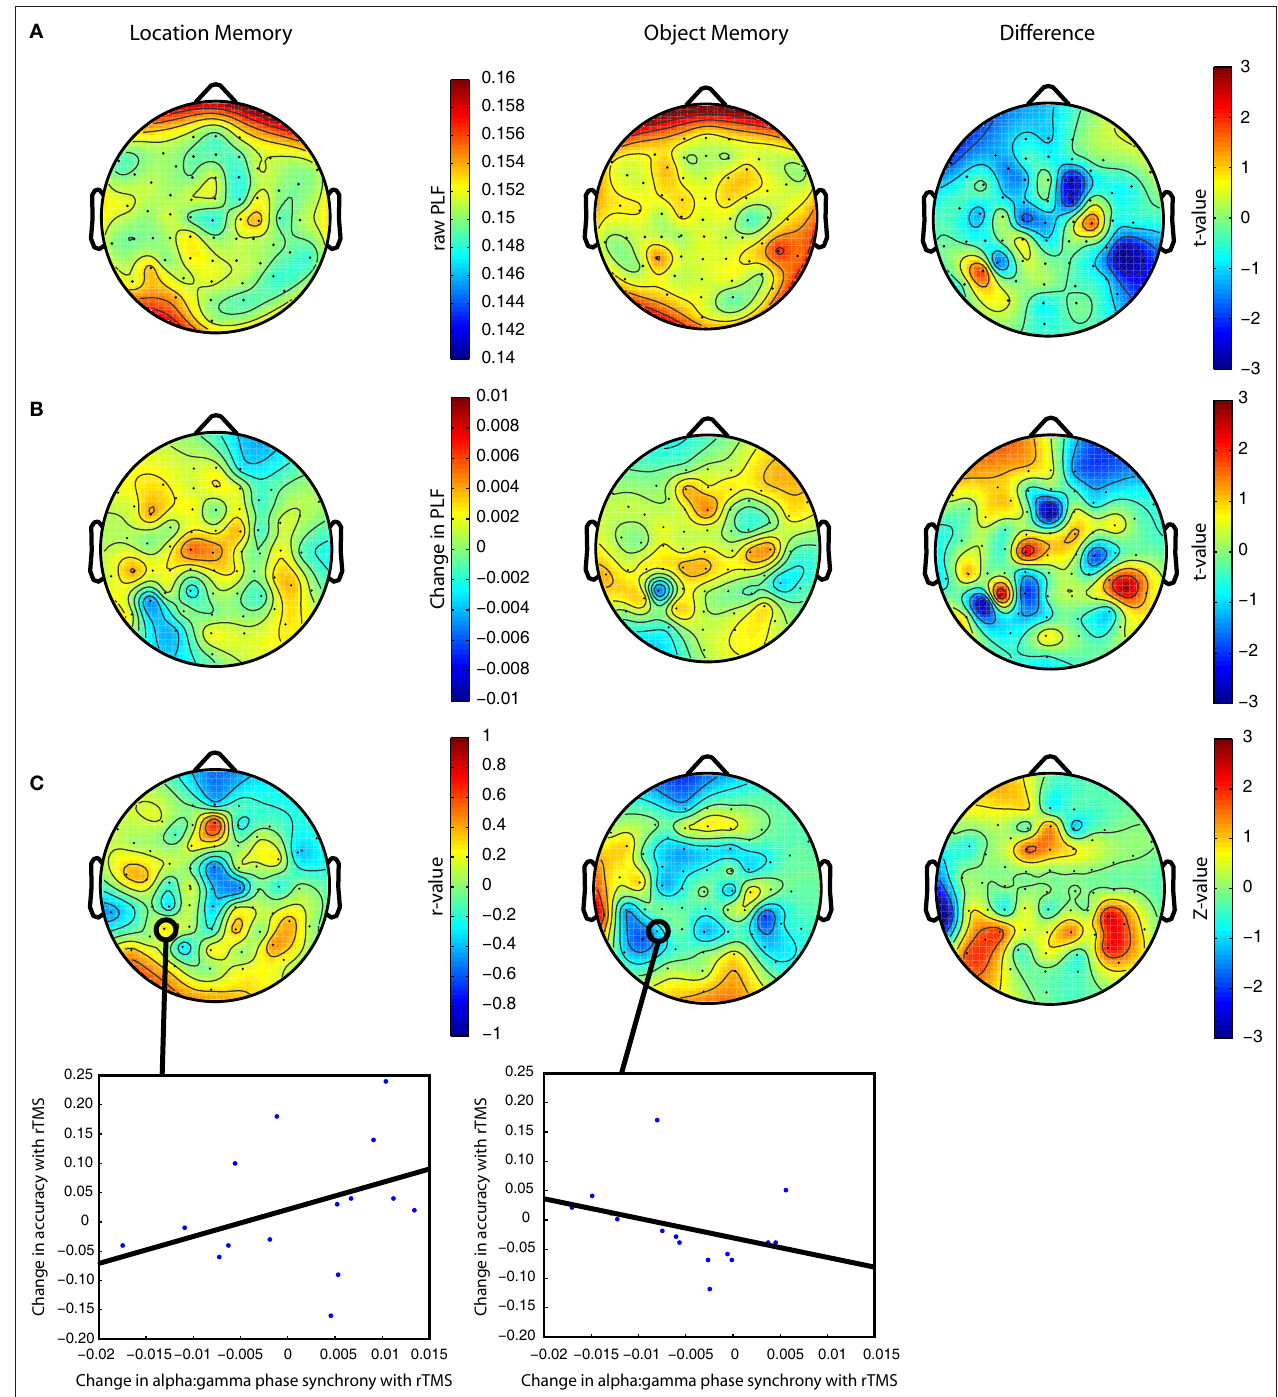
signifi cant at right posterior electrodes ( Z = 1.83–2.34 for electrodes CP6, TP8 and FIGURE 7 | (A) Raw alpha:gamma phase synchrony for location and object P6; p = 0.02–0.06) and marginally so for the left posterior electrodes ( Z = 1.75–1.87 memory in rTMS trials. Pairwise analysis reveals a greater alpha:gamma absent for electrodes P7, P5 and P3; p = 0.06–0.08). For S1 rTMS, the difference between synchronization in the right posterior electrodes during object memory trials. the correlations for the two task conditions did not reach signifi cance (there were (B) Change in alpha:gamma phase synchrony with SPL rTMS. (C) Correlation no clusters of channels with Z > 2). All plots are derived from the mean change in between SPL rTMS-induced change in alpha:gamma phase synchrony and PLF during the second half of the delay period. All plots are based on phase rTMS-induced change in accuracy ( r > 0.50 corresponds to p < 0.05). Scatter plots synchrony between 10 and 40 Hz oscillations. Analysis of synchrony between 10 show this relationship for electrode P3 (nearest the location of stimulation). The and 50 and 10 and 60 Hz reveals qualitatively similar difference between the correlations in object versus spatial memory trials was